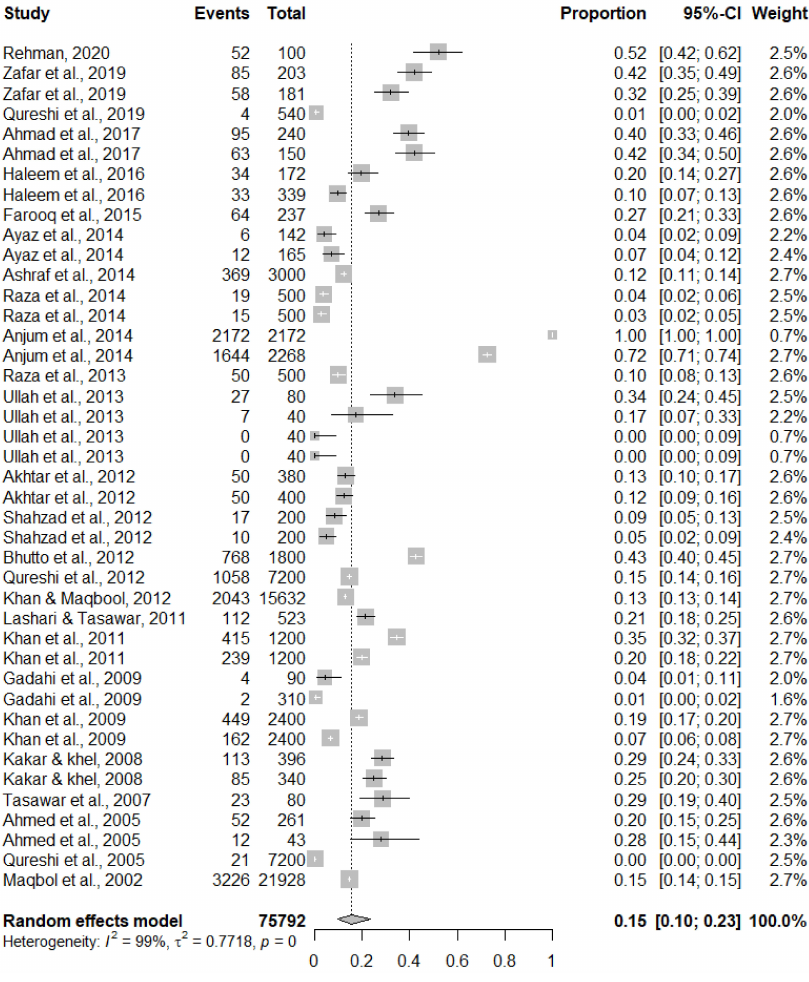
Figure 2. Forest plot diagram depicting the prevalence of fascioliasis in human and domestic animals [24–49].